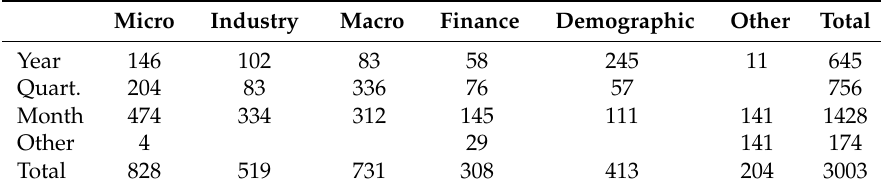
Table 4. Time series categories and attributes of the M3